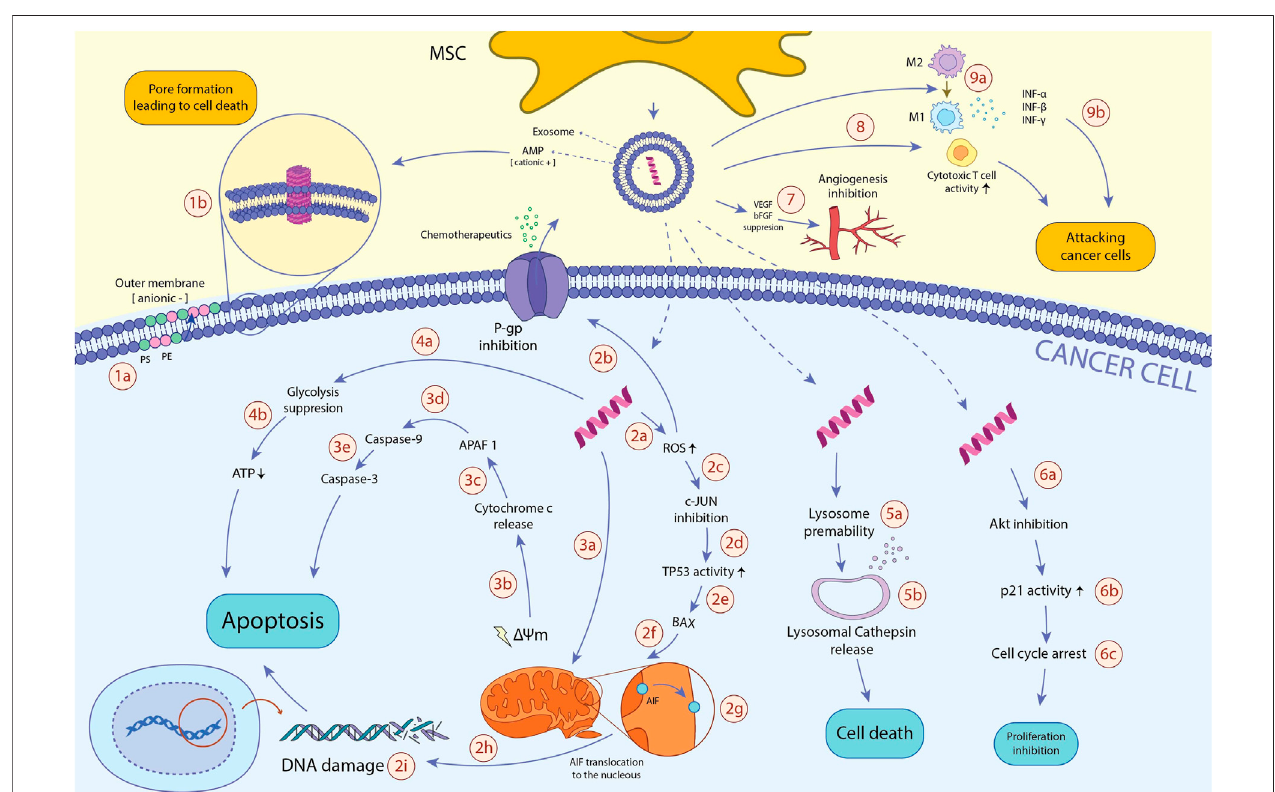
FIGURE2| Theanti-neoplasticeffectsofMSCs-derivedAMPs.AMPsreducetheviabilityofcancerouscellsthroughvariousmechanisms:1a.InTME,hypoxiaand excessiveROSamountsinducetranslocationofPSandPEfromtheinnermembranetotheoutermembraneofthecancercell,resultingintheanionicchargeoftheouter membrane and subsequent incline of the cationic AMPs. 1b. Cancer cell membrane-AMP interaction leads to membrane dysregulation, pore formation, and ultimately, cancer cell death. 2a. After entering AMP to the cancer cell, it promotes intracellular ROS production. 2b. Excessive ROS amount inhibits P-gp activity, a pump playing an essential role in chemotherapeutics ef fl ux and instating MDR,resulting in the enhanced vulnerability of cancer cells tochemotherapeutic drugs. 2c. High ROS levels also hamper c-JUN activity. 2days. When c-JUN inhibitory impacts on the TP53 tumor suppressor gene abrogates, TP53 function will be enhanced. 2e. TP53 profoundly induces BAX expression. 2f. BAX translocates to mitochondria. 2g. in the mitochondria, BAX triggers mitochondrial membrane potential ( ΔΨ m) dissipation and AIF translocation from the inner membrane to the outer membrane. 2h. AIF transfers to the nucleus. 2i. In the nucleus, AIF binds to DNA, causes DNA damage, and ultimately programmed cell death of the cancer cell. 3a. AMP disrupts mitochondrial membrane, leading to mitochondrial membrane degradation, mitochondrial swelling, and damage. 3b. Consequently, AMP dysregulates the mitochondrial membrane potential ( ΔΨ m), which leads to cytochrome c release. 3c. Cytochrome c activatesAPAF1.3days.APAF1activatescaspase-9pro-enzymeand inducesitstranslocationintothecytoplasm.3e.Activated caspase-9ultimatelytriggerscaspase- 3activity,oneofthemainenzymesthroughtheapoptosisprocess.4a.AMPsalterthecancermetabolicactivityandinhibitglycolysis,theprimaryprocessresponsiblefor ATPgenerationincancercells(knownasTheWarburgeffect).4b.glycolysisinhibitionresultsinATPdepletion,whichleadstocancercelldeath.5a.AMPsalsoaugment lysosomal membrane permeability. 5b. Increased lysosomalpermeability leadsto the release oflysosomalcathepsin into the cytosol, which fi nally initiates cytosol death signaling pathways. 6a. AMP downregulates Akt expression. 6b. downregulating Akt expression leads to enhanced p21 activity. 6c. p21 induces cell cycle arrest, leading to the diminished proliferation of the cancer cell. 7. AMPs hamper tumor-associated angiogenesis via inhibiting the function of bFGF and VEGF pro-angiogenic factors. 8a. AMPs promote the activity of cytotoxic T cells, which ultimately leads to enhanced immune system activity against cancer cells. 9a. AMPs boost macrophages ’ shifttoanti-cancerM1phenotype.9b.M1macrophagessuppresstumorgrowththroughphagocytosisandcytokinesecretionsuchasIFN- γ ,IFN- β ,and IFN- α . Abbreviations: AMP, antimicrobial peptide; TME, tumor microenvironment; ROS, reactive oxygen species; PS, phosphatidylserine; PE, phosphatidylethanolamine; P-gp, P-glycoprotein 1; TP53, tumor protein 53; BAX, Bcl-2 Associated X protein; AIF, apoptosis-inducing factor; APAF1, apoptotic protease activating factor 1; Akt, phosphorylated protein kinase B; bFGF, basic fi broblast growth factor; VEGF, vascular endothelial growth factor; IFN: interferon.